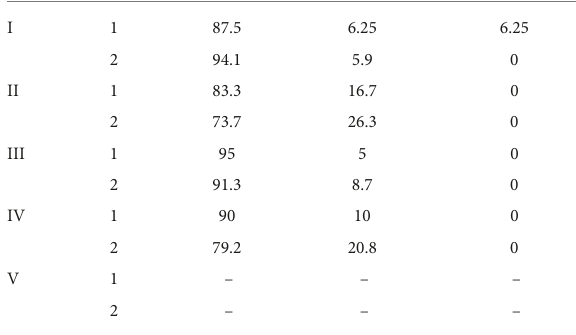
TABLE 2 Frequency of occurrence of different levels of neuropsychic strain in psychology students before classes (in